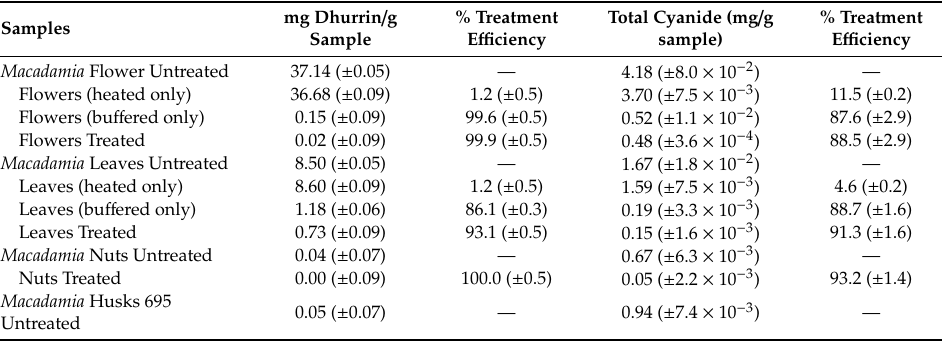
Table 2. Dhurrin and total cyanide (mg/g sample) in untreated and treated Macadamia flowers, leaves, nuts, and husk varieties and treatment removal efficiency (%). Samples